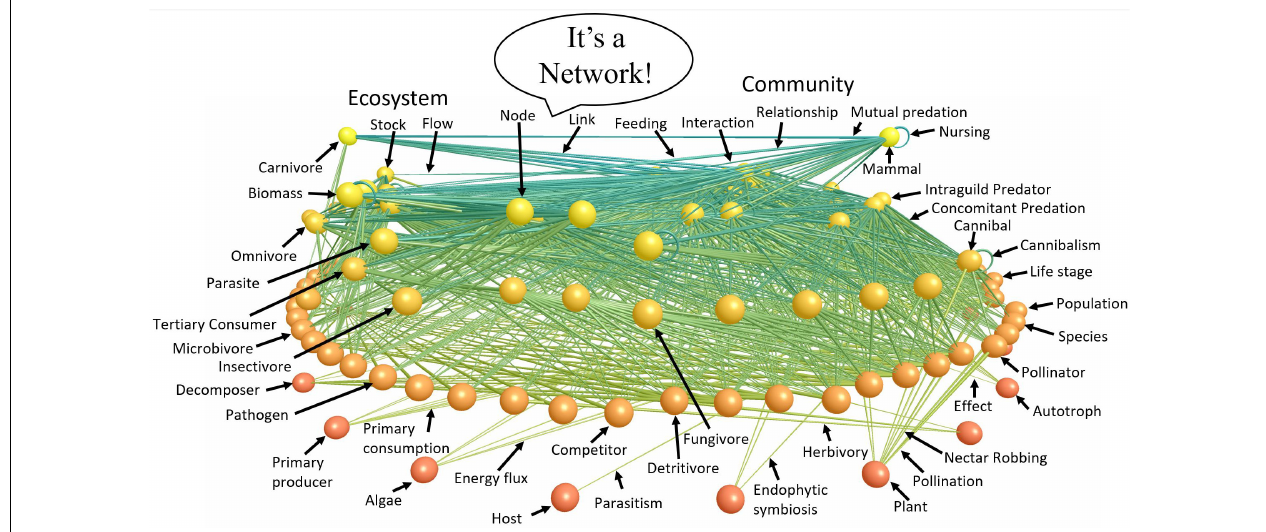
FIGURE 2 | A food web labeled with terms describing different components and aspects of the network. Nodes of the network are vertically arranged according to trophic level with autotrophs at the bottom and upper level carnivores at the top. Links between nodes represent feeding relationships. The various terms characteristic of ecology’s various subdisciplines that point to the parts of the ecological network emphasize that ecological subdisciplines study very similar entities from different perspectives. ATN theory helps synthesize these subdisciplines by focusing on the structure ( Figure 3 ) and dynamics ( Box A ) of ecological networks such as that of Little Rock Lake (Martinez, 1991) visualized (Yoon et al., 2004) and figuratively labeled